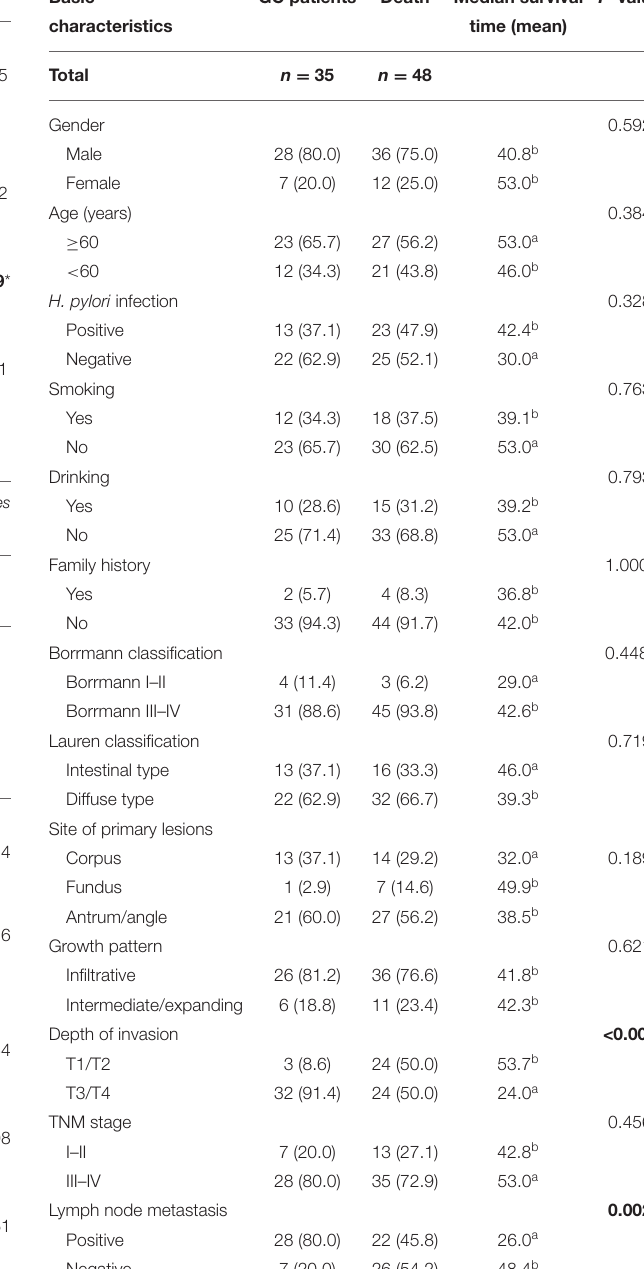
TABLE 8 | Serum TNFAIP2 protein expression between gastric cancer (GC) patients and healthy persons. Basic characteristics